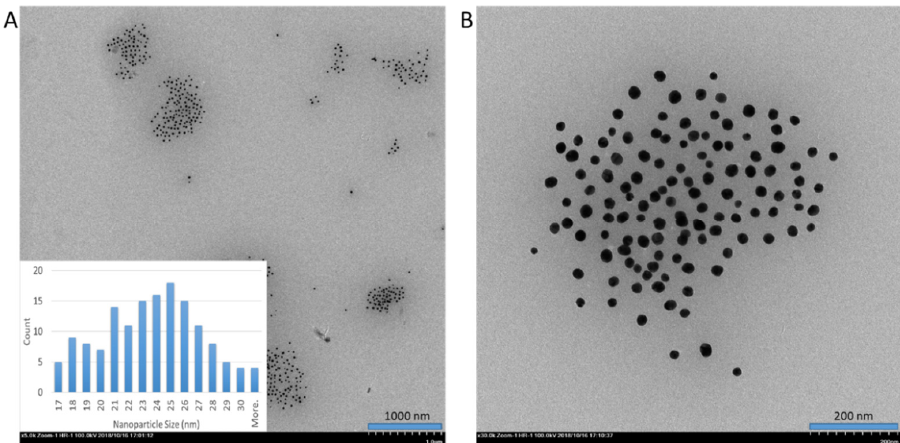
Figure 8. TEM micrographs of gold nanoparticles in toluene with octylsilane as the phase-transfer molecule. (( A ) 5.0 k zoom. ( B ) 30.0 k zoom).